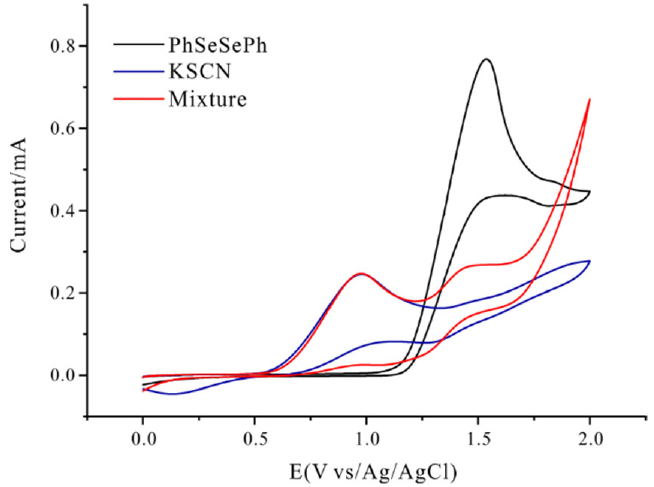
Figure 1. Cyclic voltammetry experiments. Scheme 4. Possible reaction mechanism.